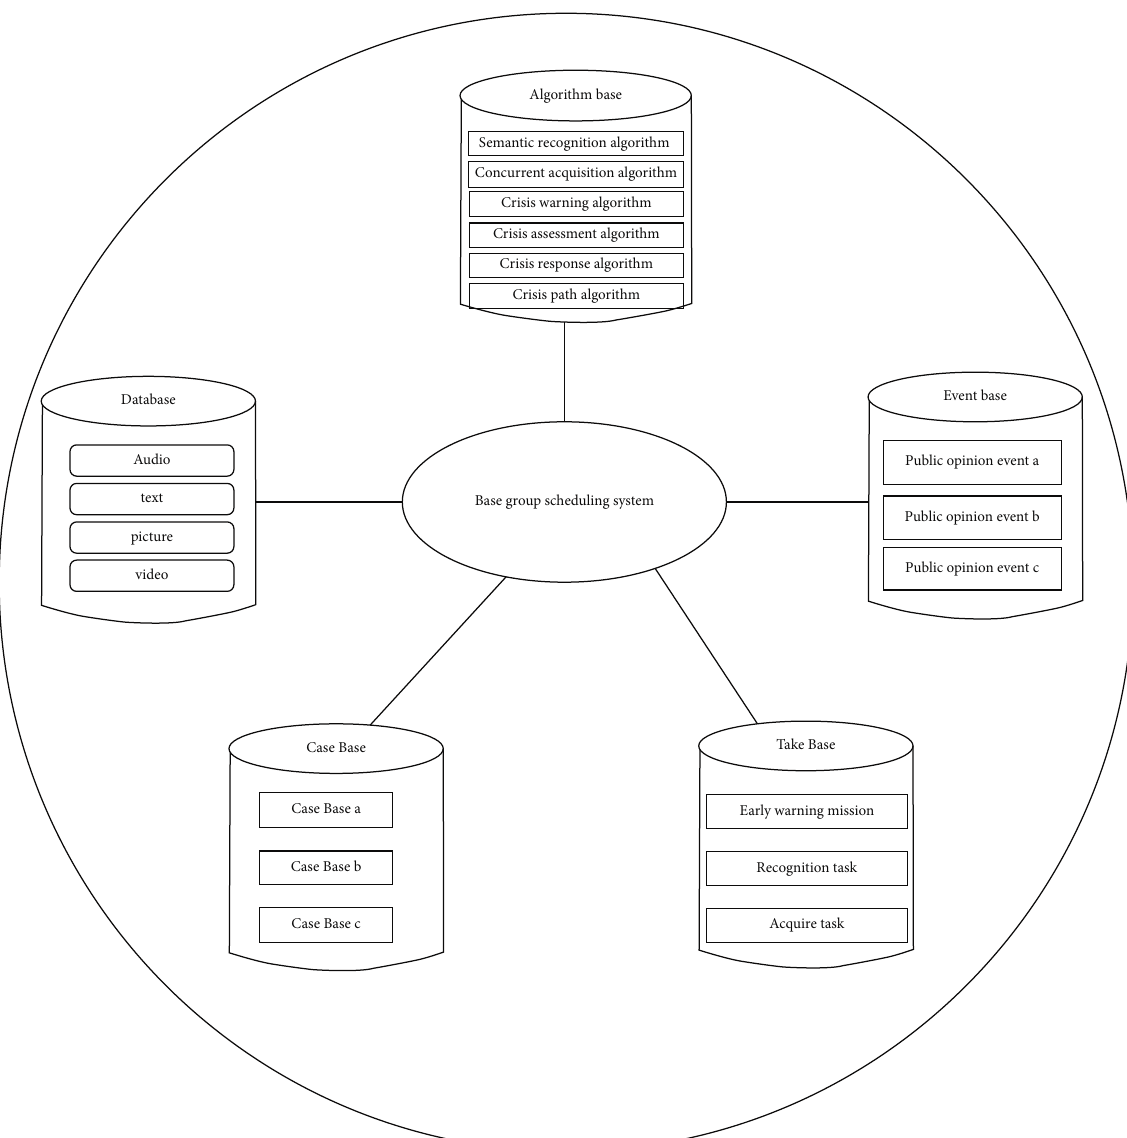
Figure 3: Interoperability scheduling control mechanism of multimedia network knowledge base group.